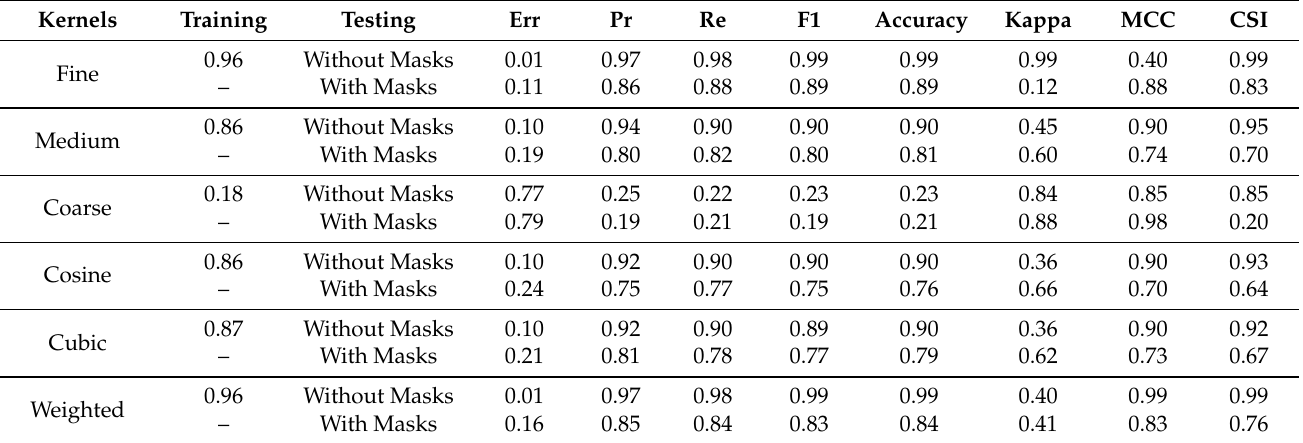
Table 6. Verification results of K-Nearest Neighbor (KNN).